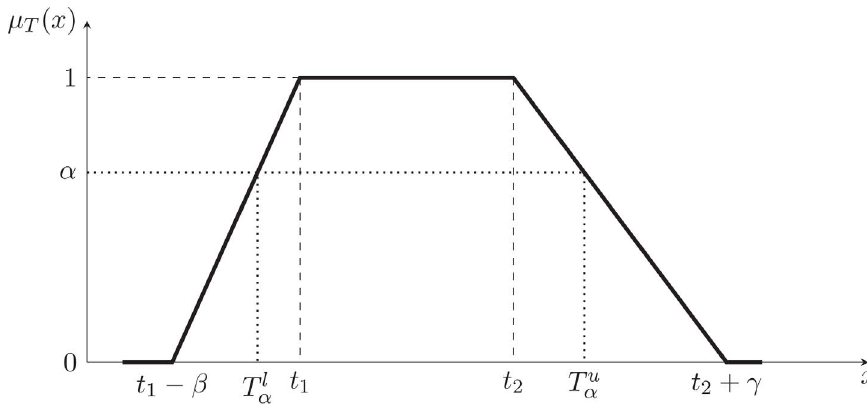
Figure 1. The membership function and a -cut of a trapezoidal fuzzy number.